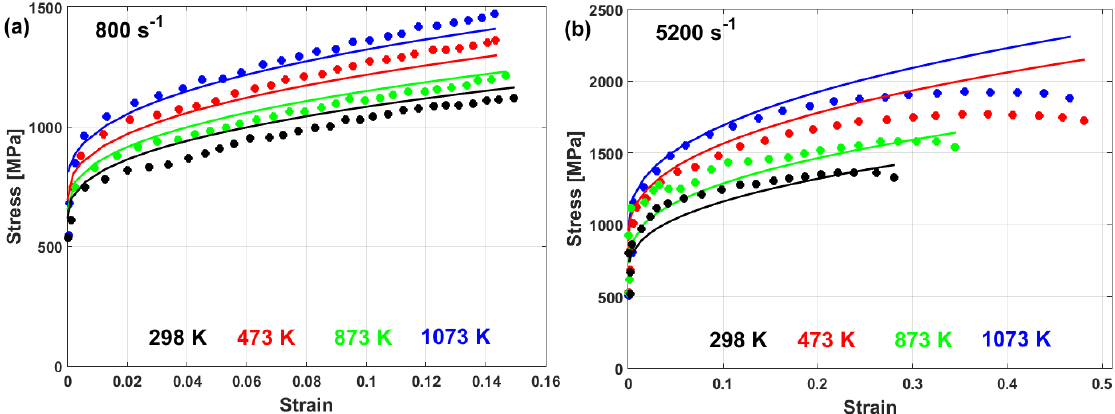
Figure 32. Comparison between experimental stresses (markers) and predicted stresses for GH4133B using the modified JC model that was presented by Wang et al. [83] at ( a ) 800 s −1 and ( b ) 5200 s −1 .